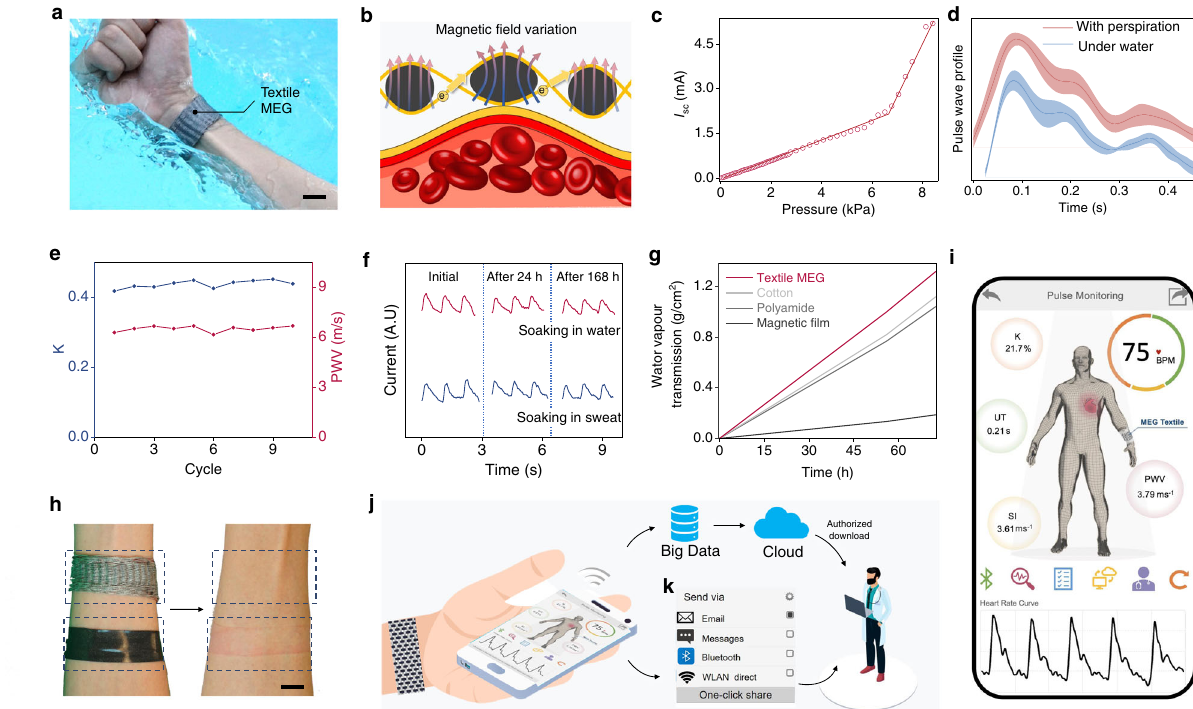
Fig. 4 Measuring cardiovascular parameters underwater without encapsulation for telehealth. a Photograph of the textile wristband as a wearable pulse sensor. Scale bar: 2 cm. b Schematics of the working principle of the textile wristband. c Sensitivity of the textile MEG with respect to applied pressure at a frequency of 1 Hz. d Measured pulse wave pro fi le in one cardiac cycle when the encapsulation-free textile wristband was tested with perspiration and under water. The shadow areas indicate the standard deviation of the results from fi ve pulse wave pro fi les. Data are mean ± SD; n = 5. e Characteristic K value and PWV obtained from pulse wave signals. f Measured pulse wave pro fi les when textile wristband was soaked in actual sweat and water for up to 168 h. The pulse wave in blue color was tested in actual perspiration status. g A water vapor transmission rate test showing the perspiration transmission through the textile MEG. h Photograph showing the skin irritation results of the permeable textile MEG and an impermeable magnetic fi lm on the forearm. Scale bar: 1.5 cm. i The developed user interface on a cellphone APP. j Schematic of a fully integrated CMS. The personal health data could be processed via two pathways: directly sending to the physicians for immediate clinical diagnosis, or uploading into the cloud to conduct big data analysis for data-driven diagnosis. k Screenshot of mobile user interface showing the personal health data sharing